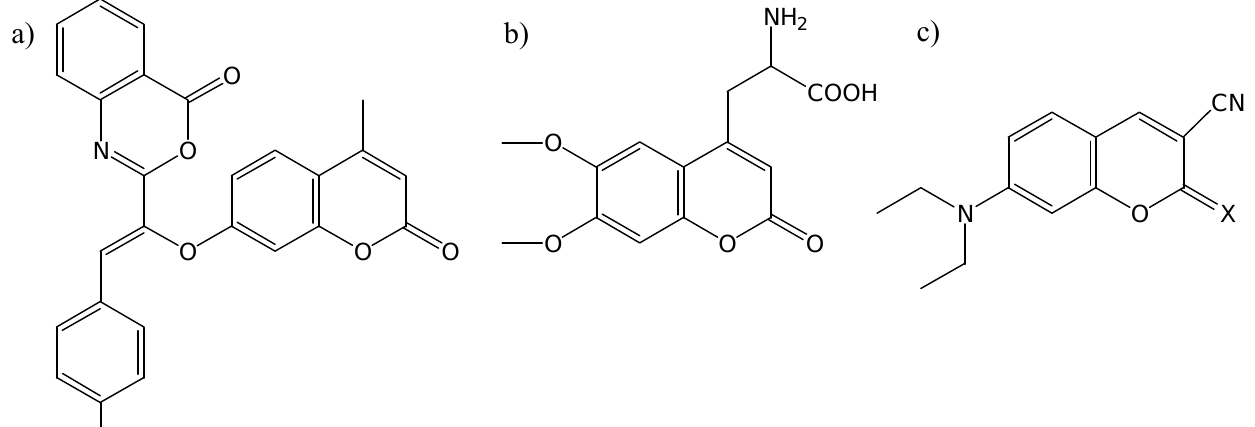
CH ); b) a coumarin-based amino acid 2 3